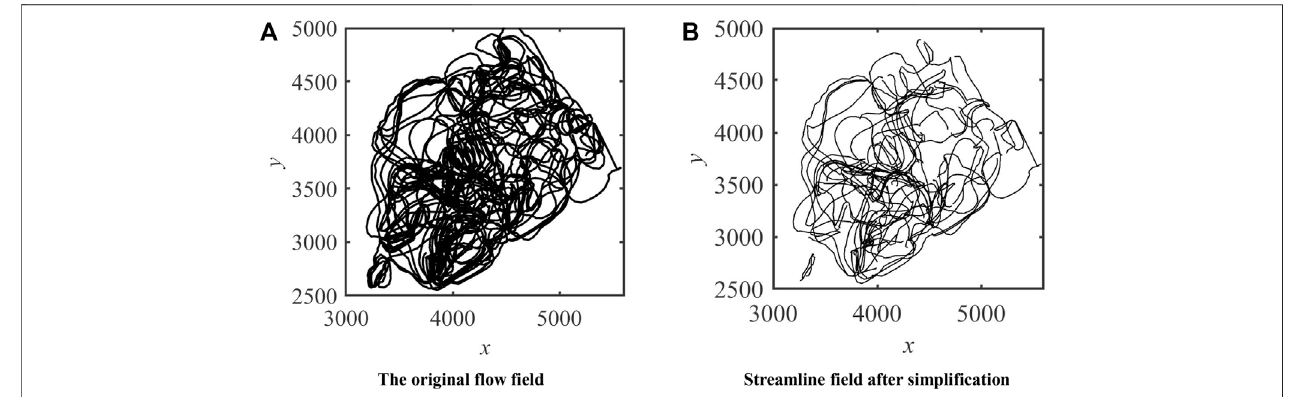
FIGURE 9 | Streamline simpli fi cation based on clustering.